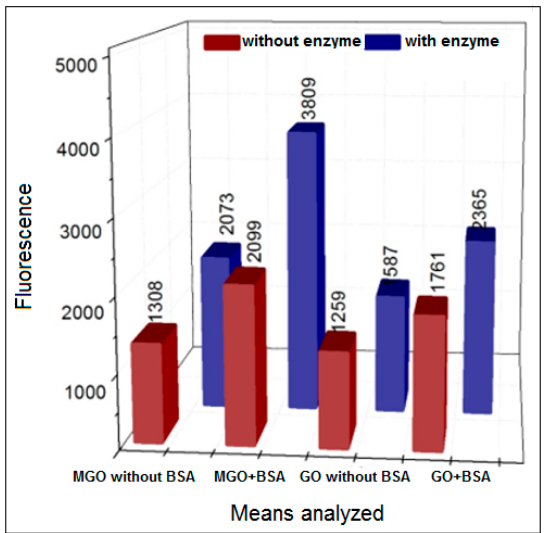
Figure 5. Formation of AGEs using methylglyoxal (MGO) and glyoxal (GO) (37 °C) in the presence or absence of XO in pure phosphate buffer (pH = 6.6) with 5 h incubation.